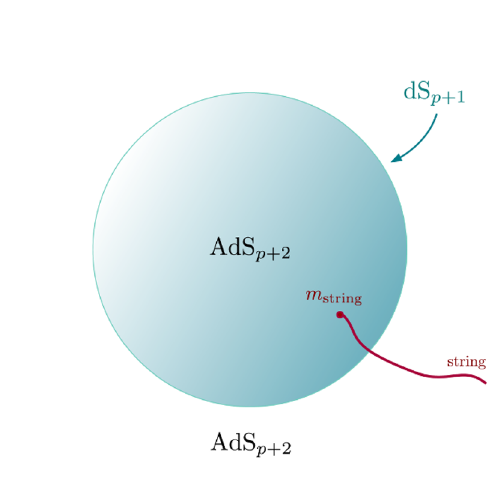
Figure 7 . A bubble which interpolates between two AdS p +2 space-times, hosting a dS p +1 geometry on its world-volume. Open strings with a single endpoint attached to the bubble wall give rise to massive particles on the